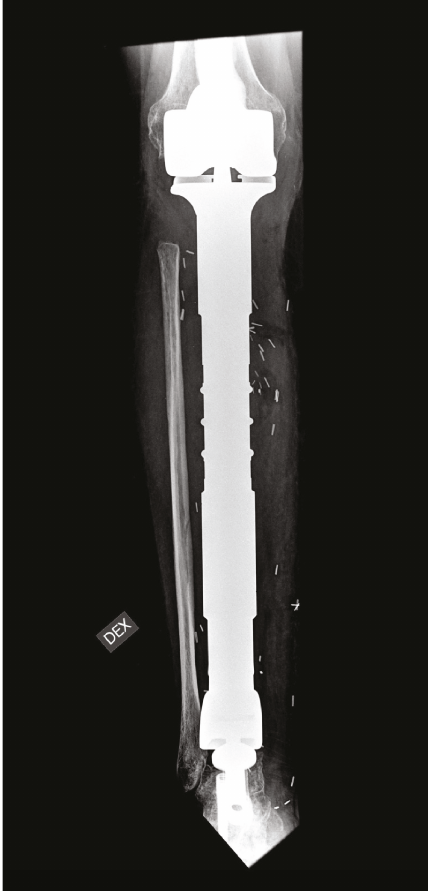
Figure 3: Postoperative X-ray from a right tibia. The knee joint was reconstructed with a metal-on-poly articulation with a (unique) metal-on-metal hinge mechanism, and the ankle joint was reconstructed with a metal-on-poly hinge joint with a talar replacement, stabilized with a trans-talar and trans-calcanear hydroxyapatite-coated stem. A supplementary screw was used to add stability in the subtalar joint.